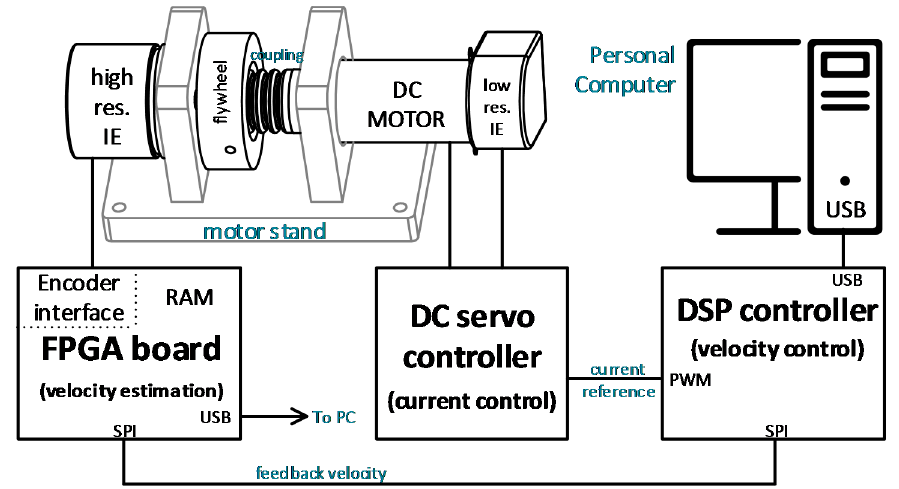
Figure 10. The scheme of the experimental system.